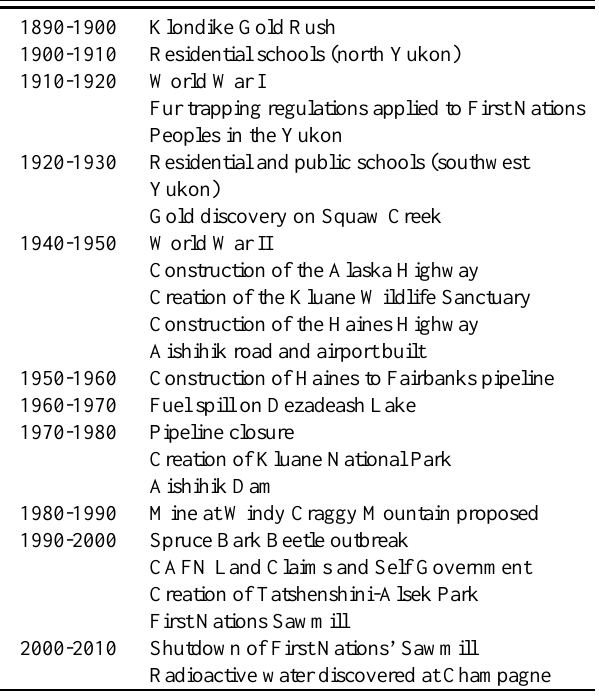
Table 1. Local historical change in southwest Yukon. CAFN = Champagne and Aishihik First